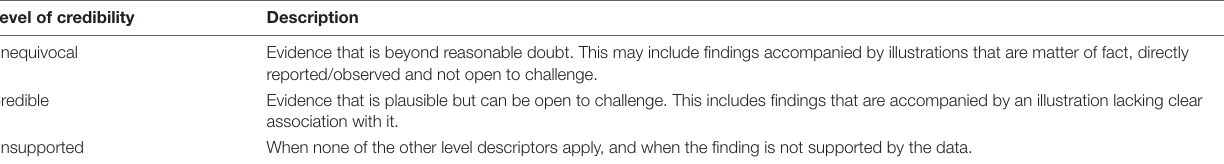
TABLE 2 | Levels of credibility and their